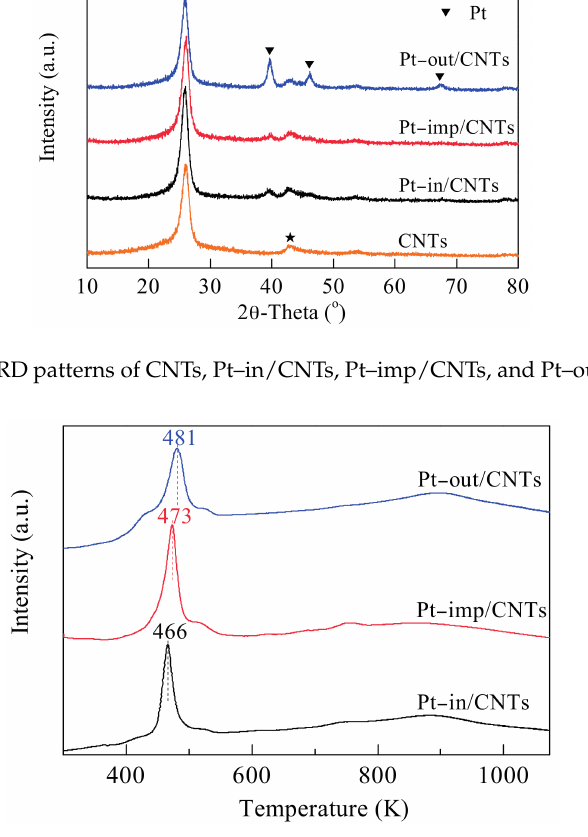
Figure 4. H 2 –TPR (temperature programmed reduction) profiles of Pt–in/CNTs, Pt–imp/CNTs, and